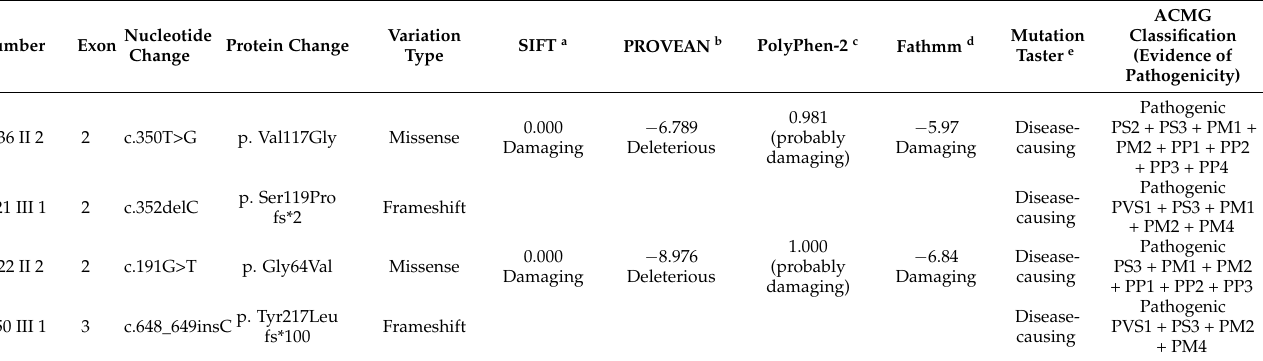
Table 1. Functional impact prediction of PAX9